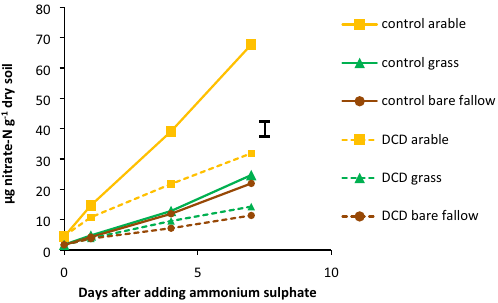
Figure 1. Production of nitrate in response to 100 mg ammonium-N g −1 dry soil added to microcosms incubated for 7 d with no inhibitors (solid lines) or 200 µM dicyandiamide (DCD) (dashed lines); standard error of difference of means ( P < 0.001) shown as bar.